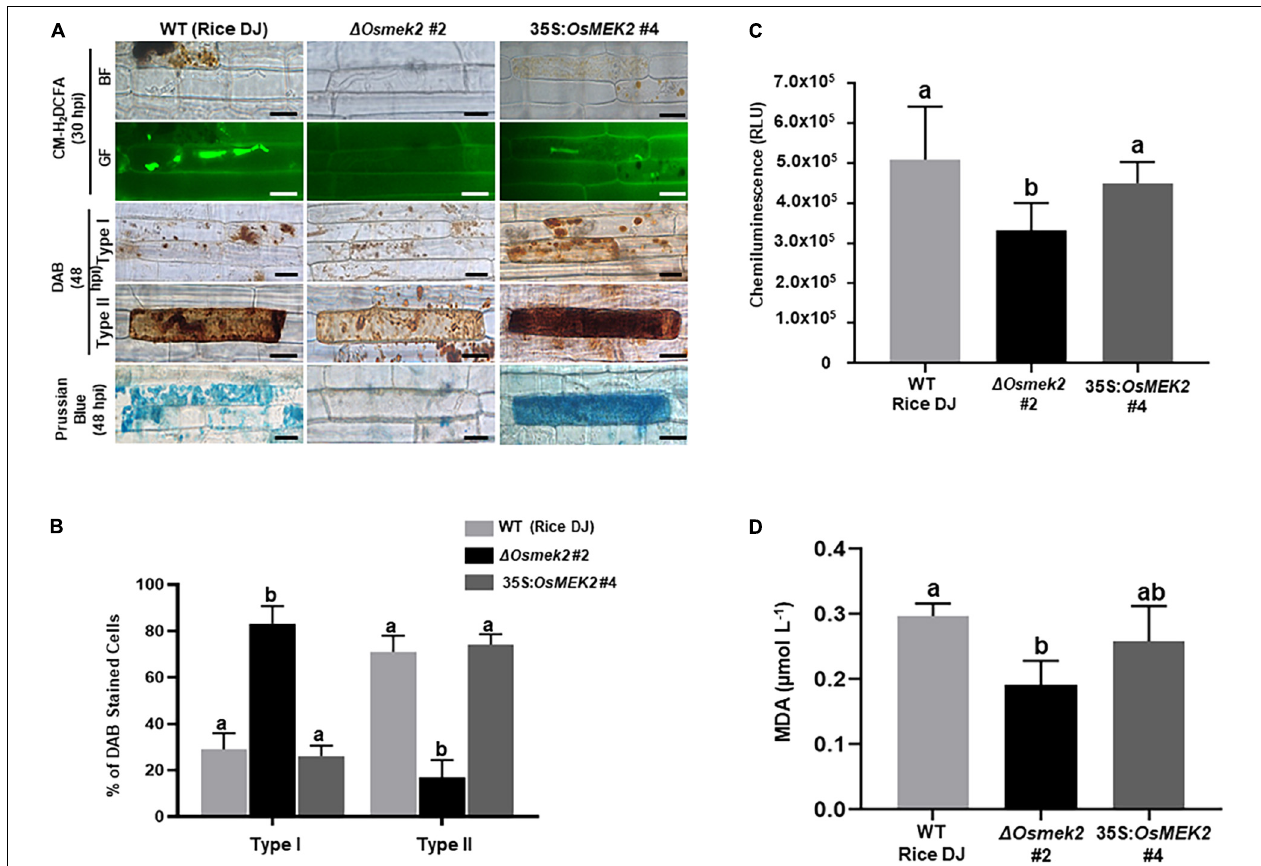
FIGURE 5 | OsMEK2 knock-out and overexpression in wild-type rice DJ differentially regulates ROS and ferric Ion (Fe 3 + ) accumulation and lipid peroxidation in leaf sheaths infected with avirulent Magnaporthe oryzae 007. (A) CM-H 2 DCFDA (green fluorescence), DAB, and Prussian blue (blue color) staining shows accumulation of ROS (H 2 O 2 ) and ferric ion (Fe 3 + ) in rice leaf sheath epidermal cells of the wild-type (WT) rice cultivar DJ, OsMEK2 knock-out ( (cid:49) Osmek2 #2) and OsMEK2- overexpressed (35: OsMEK2 #4 ) plants during M. oryzae infection. Scale bar = 20 µ m. (B) Quantification of DAB-stained cells at 48 h after inoculation. The DAB-stained cells were categorized into two phenotypes: Type I, infected cells that display no or weak DAB staining; and Type II, infected cells that display strong DAB staining. Results are presented as mean values ± SD; n = 4 leaf sheaths from different plants. (C) Quantification of ROS production in rice leaf sheaths at 48 h after inoculation. ROS production was quantified by a luminol-based assay using a GloMax R (cid:13) 96 Microplate Luminometer (Promega). Values are means ± SD of total relative luminescent units (RLU) ( n = 10). (D) Lipid (MDA) peroxidation determination in rice leaf sheaths at 48 h after inoculation. Results are presented as mean values ± SD; n = 4 leaf sheaths from different plants. Images were captured using a fluorescence microscope (Zeiss equipped with Axioplan 2) with bright field and a combination of excitation (450–490 nm) and emission (515–565 nm) GF filters. Experiments were repeated three times with similar results. Different letters above the bars indicate significantly different means ( P < 0.05), as analyzed by Fisher’s protected least significant difference (LSD) test. BF, bright field; GF, green fluorescence; hpi, hours post-inoculation; MDA,